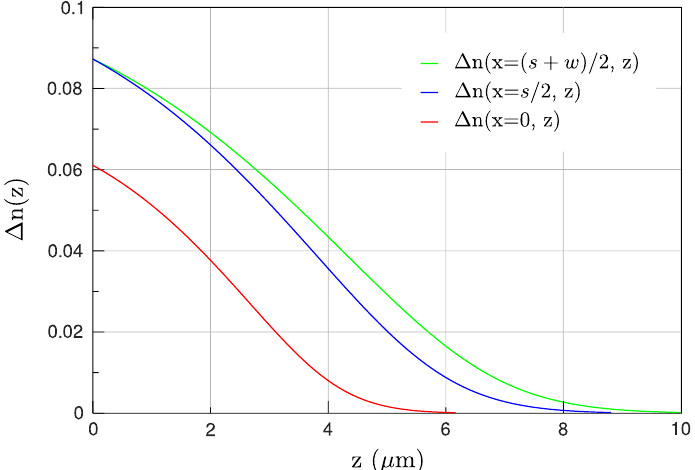
Figure 3. Typical in-depth refractive index changes after an ion-exchange process through an opening for three side positions: middle of the opening (green curve), the edge of the mask (blue line), and the middle of the transition region (red